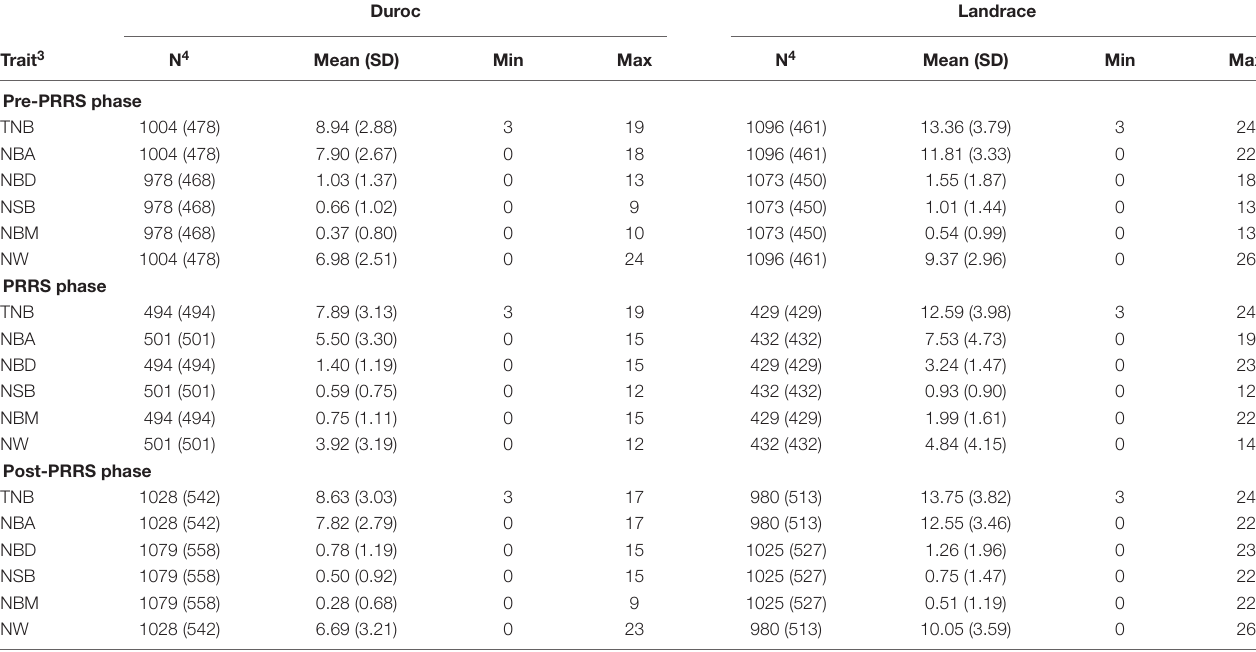
TABLE 3 | Summary statistics of reproductive traits 1 by PRRS 2 phase and breed.